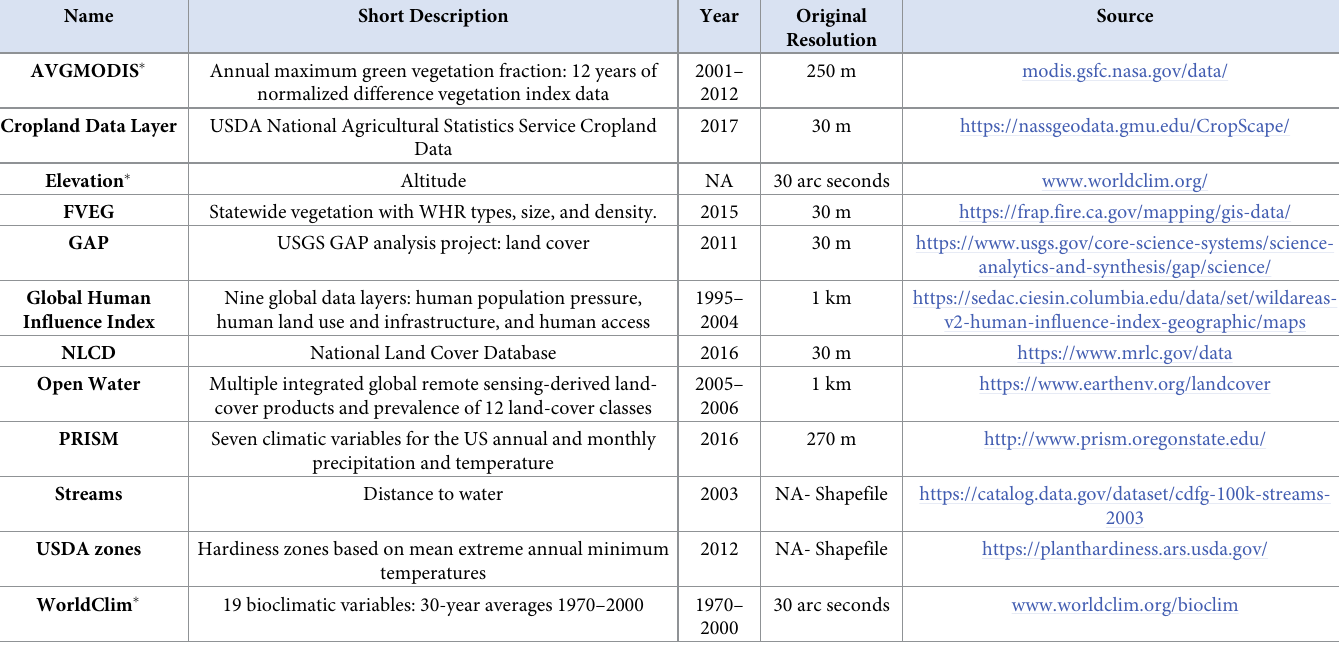
Table 1. Predictor layers assessed during variable selection for Maximum Entropy model